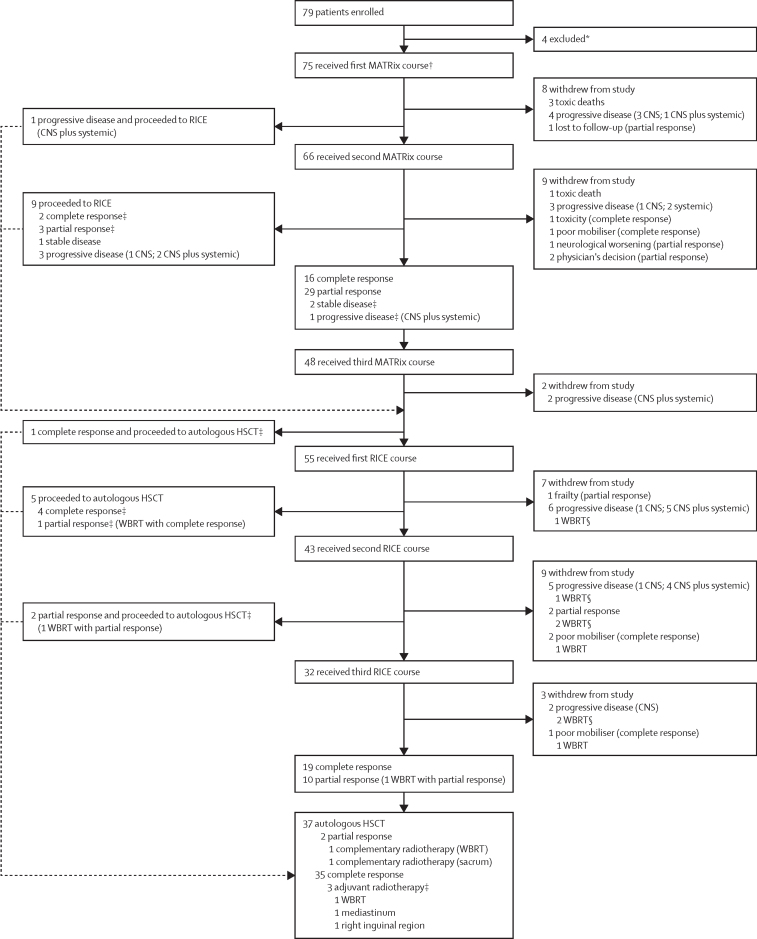
Trial profileHSCT=high-dose chemotherapy supported by autologous haematopoietic stem-cell transplantation. MATRix=rituximab, methotrexate, cytarabine, and thiotepa. RICE=rituximab, ifosfamide, carboplatin, and etoposide. WBRT=whole-brain radiotherapy. Adjuvant radiotherapy is radiotherapy used in patients in complete remission after autologous HSCT. Complementary radiotherapy is irradiation of residual lesions in patients in partial response after autologous HSCT. *Four patients were excluded because of unrelated laboratory abnormalities (n=2), disease only at flow cytometry examination of the cerebrospinal fluid (n=1), and death at the same time as registration (n=1). †Per protocol, MATRix was preceded by debulking R-CHOP (rituximab, cyclophosphamide, doxorubicin, vincristine, and prednisone) in nine (28%) of the 32 patients enrolled at original lymphoma diagnosis. ‡Protocol deviations. §Patients still had progressive disease after the WBRT.